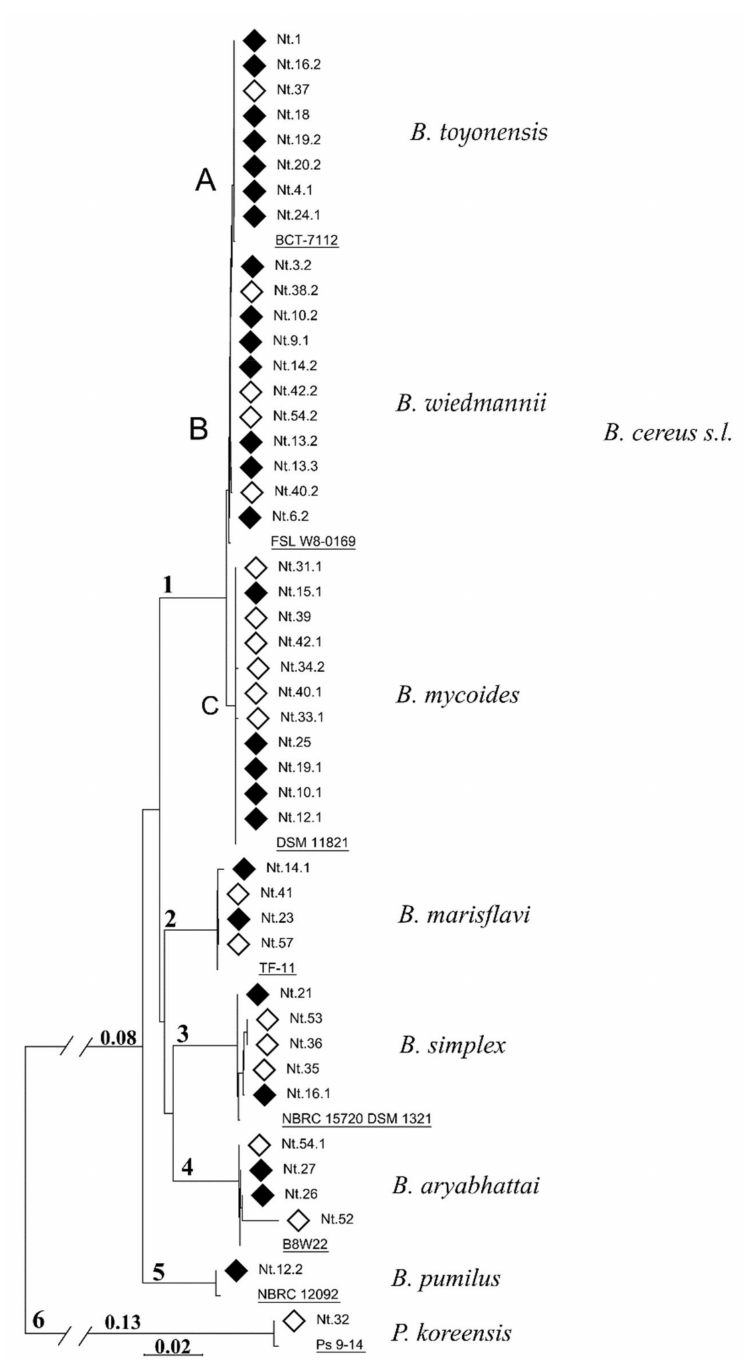
Figure 1. Phylogenetic relationship of endophytic bacteria isolated from common tobacco leaves. The tree was built using a neighbor-joining algorithm [54] using trimmed 16S rRNA gene sequences. The isolates were assigned to six distinct phylogenetic clades (1–6), and clade 1, representing B. cereus s.l. , was further divided into three subclades (A–C) according to the taxonomic identity. The taxonomic assignment of the phylogenetic clusters was based on the reference strains (underlined), that were obtained either through the querying of the genome data of representative isolates (Nt.18, Nt.37 and Nt.3.2) in the GTDB and TYGS databases for clusters 1A–B (Table A2) or using an NCBI BLAST search for the remaining clusters (Table A1). The scale bar represents the relative phylogenetic distance. Bacteria isolated from leaves of tobacco grown on non-sterile and autoclaved peat substrate are indicated by black and white diamonds,